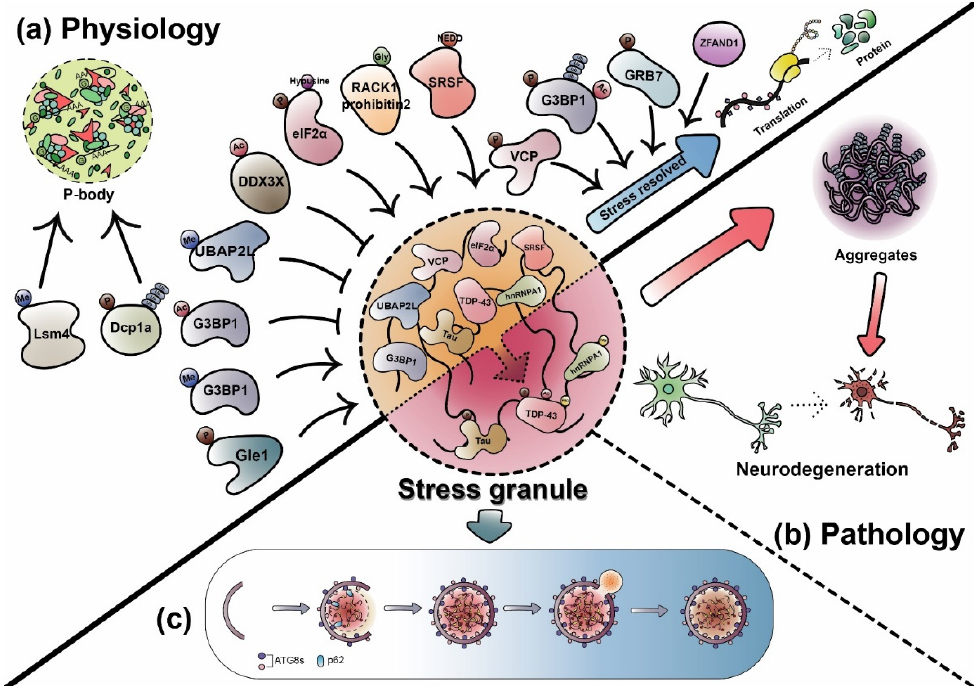
Figure 2. Physiological/pathological RNP granules regulated by PTMs. ( a ) Physiological RNP granules composed of proteins modified by PTMs, such as arginine methylation, phosphorylation, acetylation, ubiquitination, and glycosylation. PTMs can regulate RNP granule dynamics by affecting the interaction strength between proteins and nucleic acids. ( b ) RNP-binding proteins linked to neurodegenerative diseases can be modified by phosphorylation, acetylation, or PARylation (Figure 3), altering the biophysical properties. Accumulation of aggregates associated with altered RNP granules in neurons is a hallmark of several neurodegenerative diseases. ( c ) Abnormal RNP granules and aggregates can be degraded by